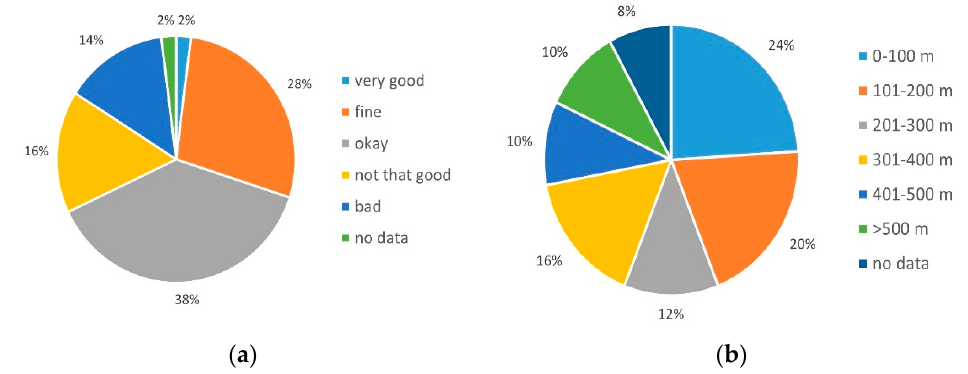
Figure 1 . The characteristics of the study group: ( a ) age (Y-years), ( b ) sex, ( c ) marital status . Of the patients, 68% ( n = 34) rated their state of health as okay to very good (Figure 2a), which was expressed in terms of the physical resilience in 48% ( n = 24) of the re- spondents with a walking distance of more than 200 meters in six minutes (Figure 2b). with a walking distance of more than 200 meters in six minutes (Figure 2b).